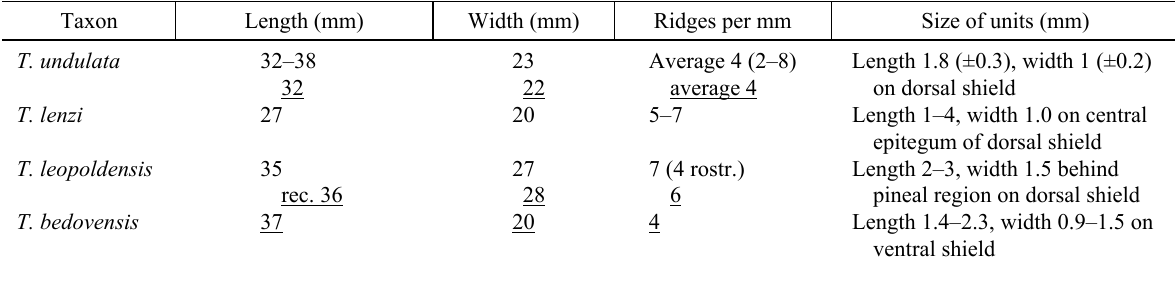
Table 3. Comparison of Tolypelepis species. Explanations: rec., reconstructed measurement; rostr., measurement on rostral epitegum; ventral measurements underlined; data for Tolypelepis lenzi from Dineley & Loeffler (1976) and for T. leopoldensis from Loeffler & Jones (1977); size of units for T. undulata from Deck (2015) Taxon Length (mm) Width (mm)